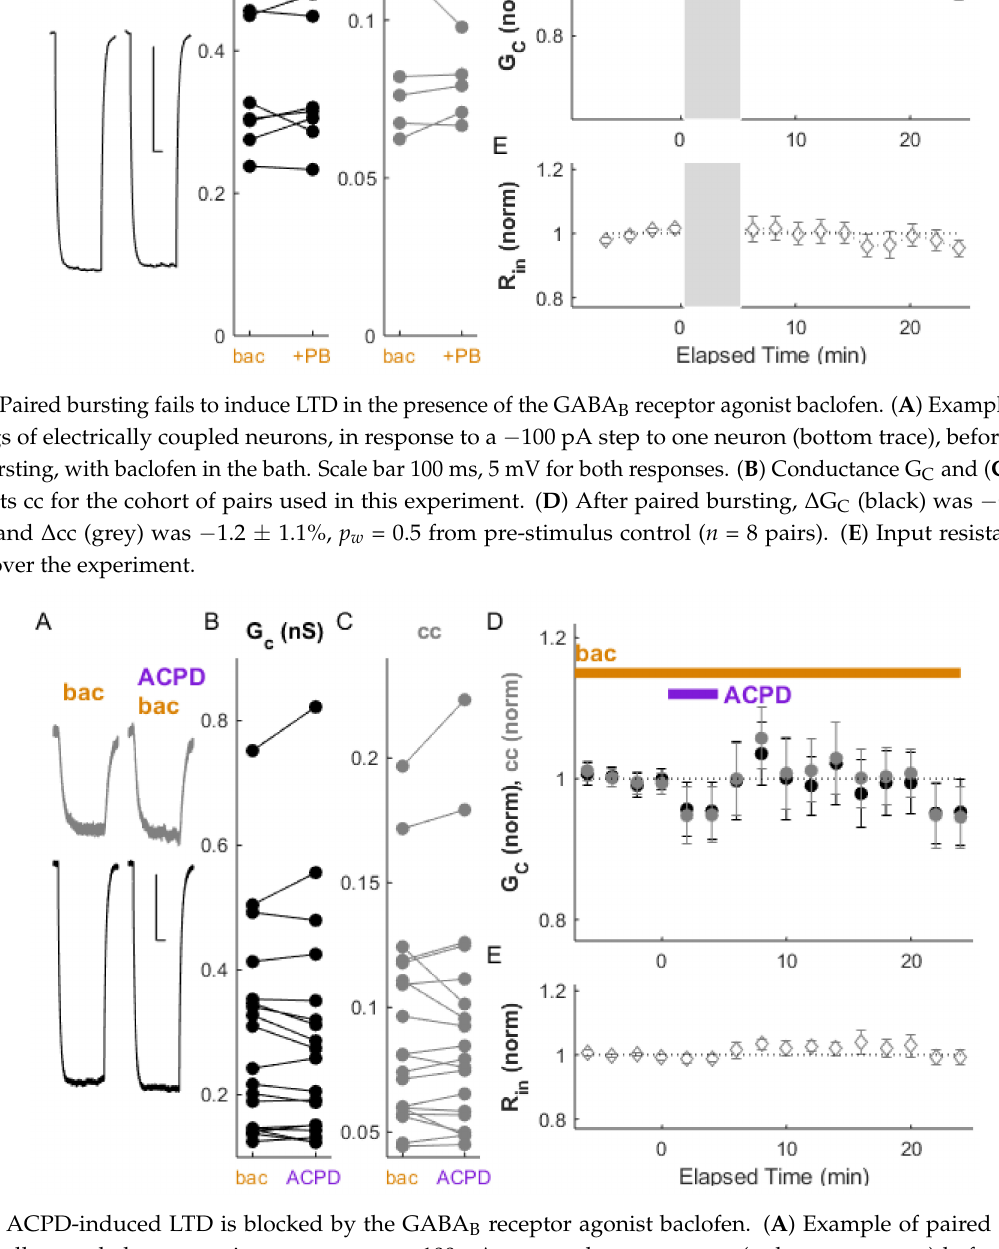
Figure 7. ACPD-induced LTD is blocked by the GABA B receptor agonist baclofen. ( A ) Example of paired recordings of electrically coupled neurons, in response to a − 100 pA step to the one neuron (to bottom neuron) before and after ACPD application, in the constant presence of baclofen. Scale bar 100 ms, 5 mV (injected neuron), 10 mV (passive neuron). ( B ) Conductance G C and ( C ) coupling coefficients cc for the cohort of pairs used in this experiment. ( D ) After 4 min of ACPD exposure (50 µ M), ∆ G C (black) was − 1.2 ± 1.1%, p w = 0.38, and ∆ cc (grey) was − 0.58 ± 0.97%, p w = 0.65 from pre-stimulus control ( n = 19 pairs). ( E ) Input resistance for all neurons over the